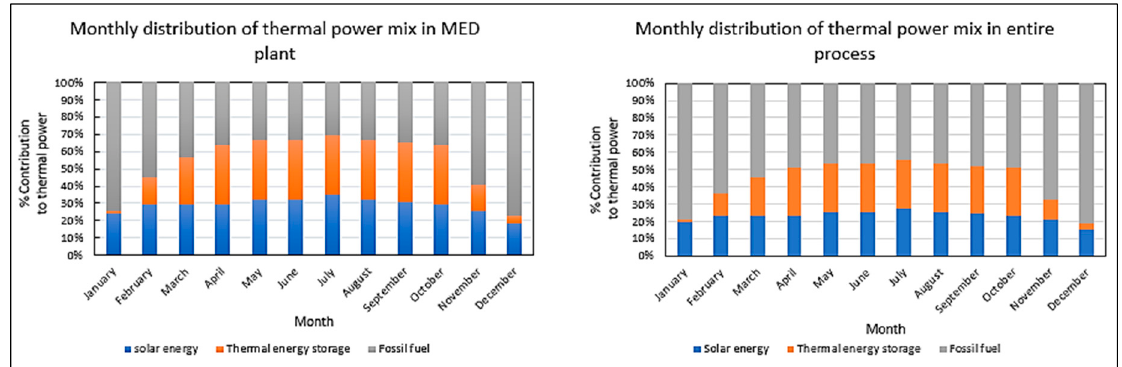
Figure 5. Optimal thermal power mix for the MED plant and the entire system with 60% RO 40% MED